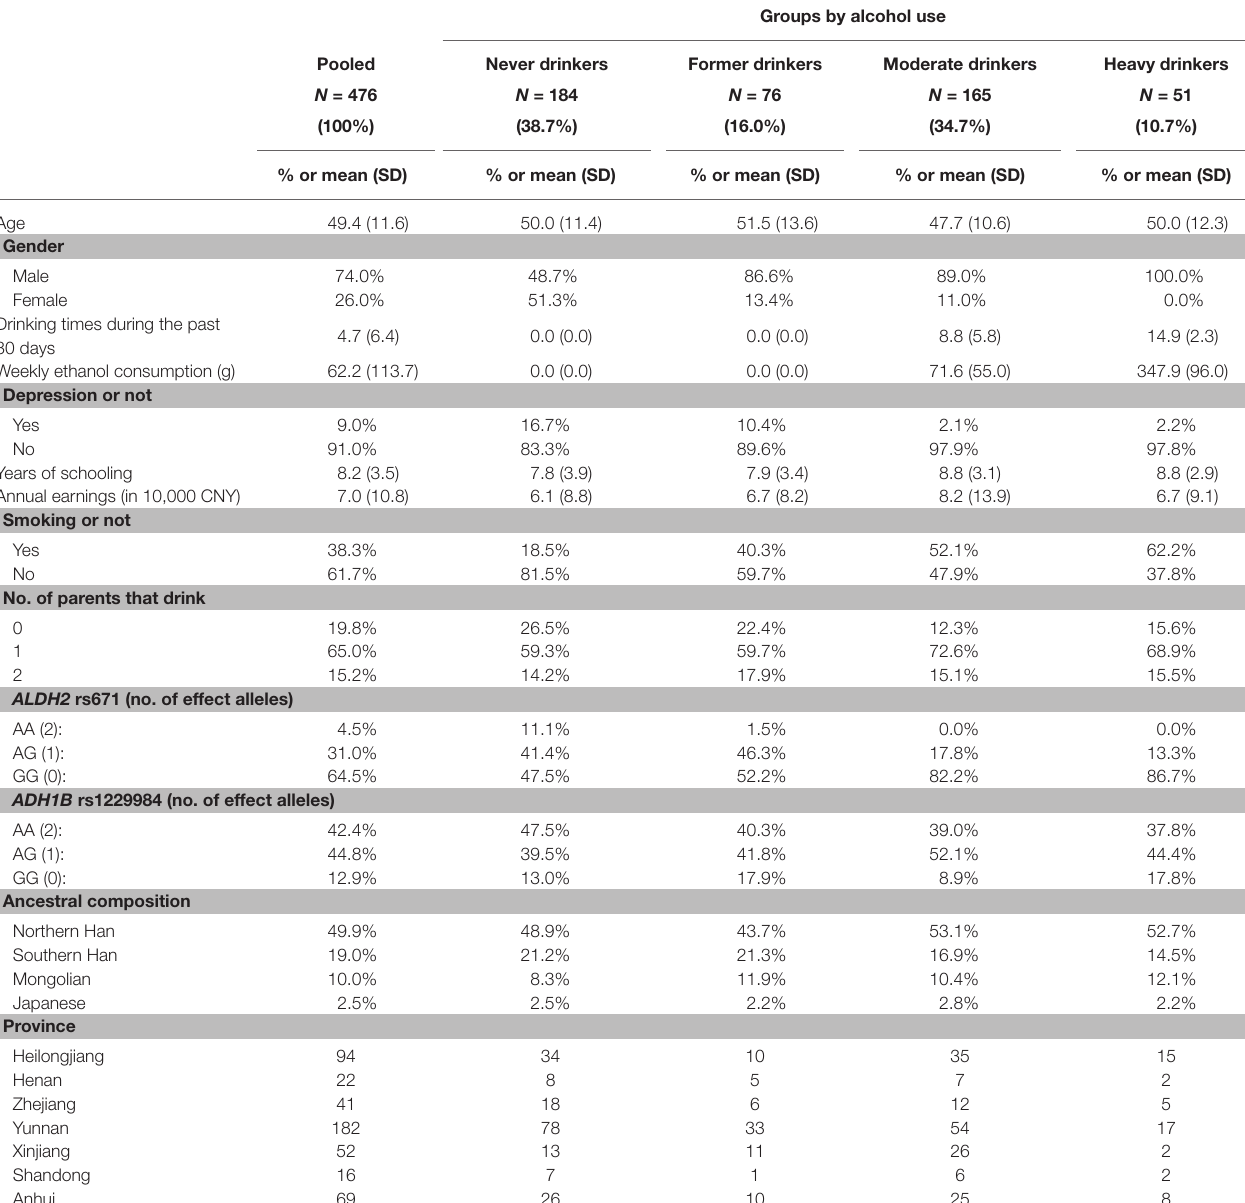
TABLE 1 | Demographic, socioeconomic and genetic characteristics of participants according to their groups of alcohol use ( N =